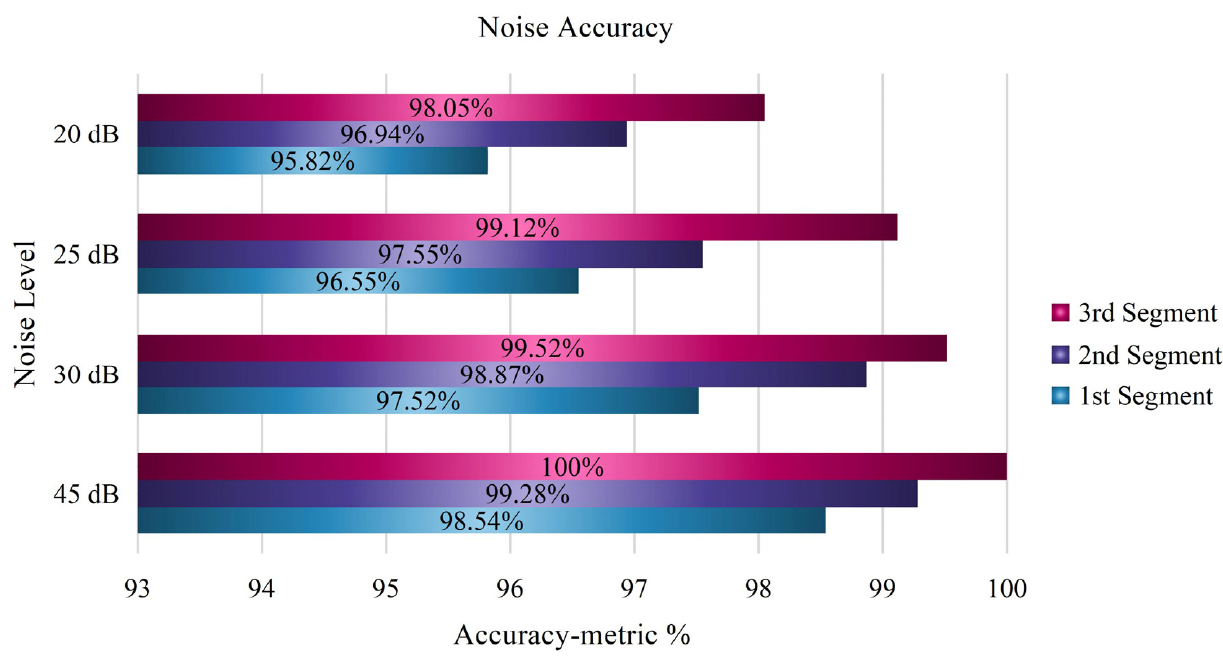
Figure 12. ANN results under the different noisy event.